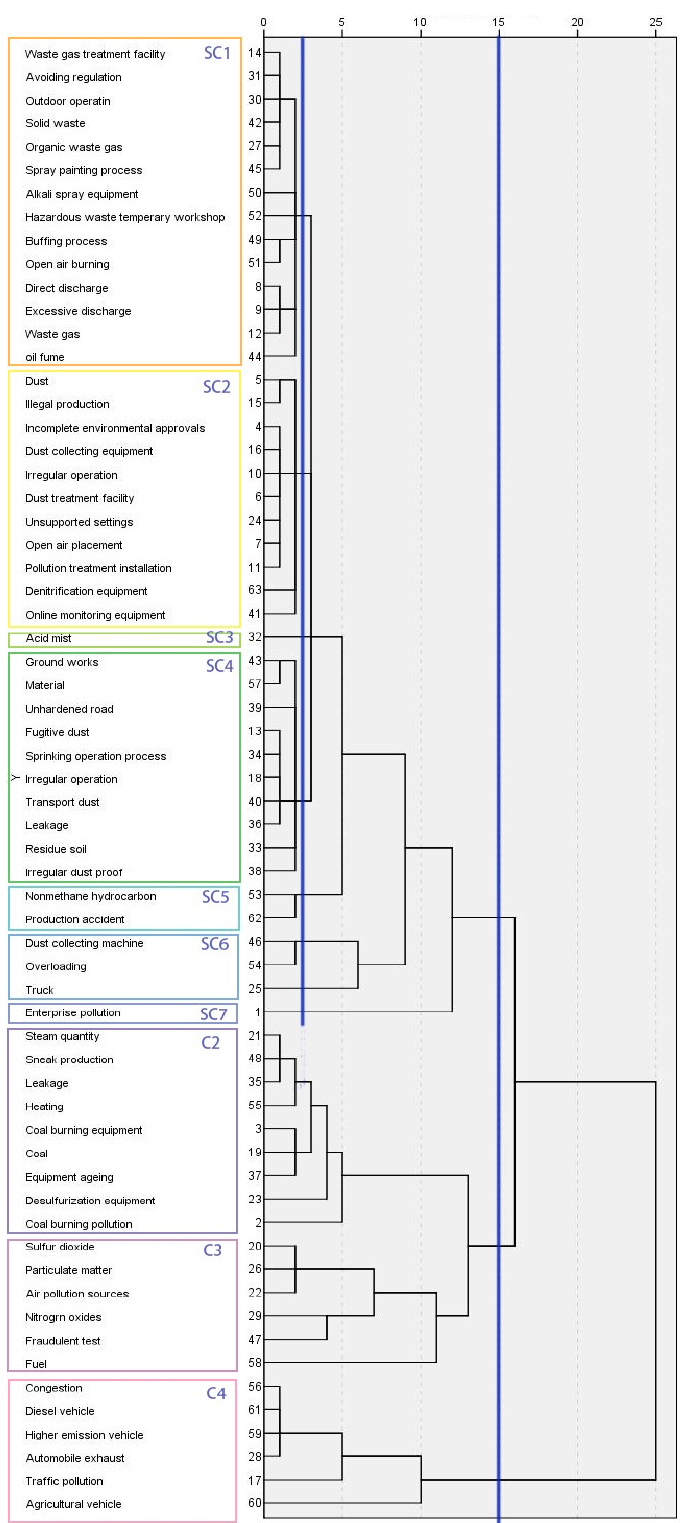
Figure 5. Dendrogram of keywords.